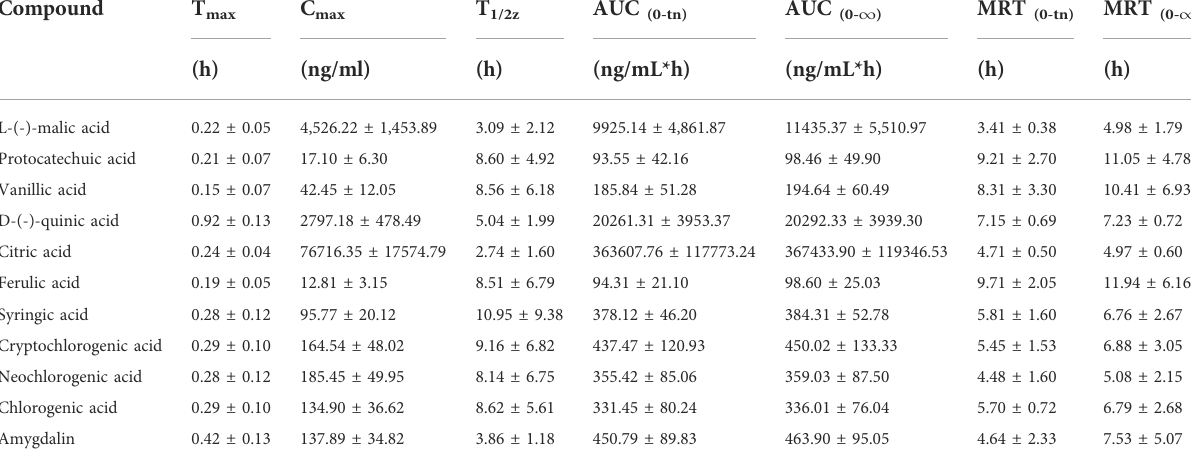
TABLE 5 Pharmacokinetic parameters of 11 analytes in normal administration and model administration groups of rats. (Mean ± SD, n = 6).